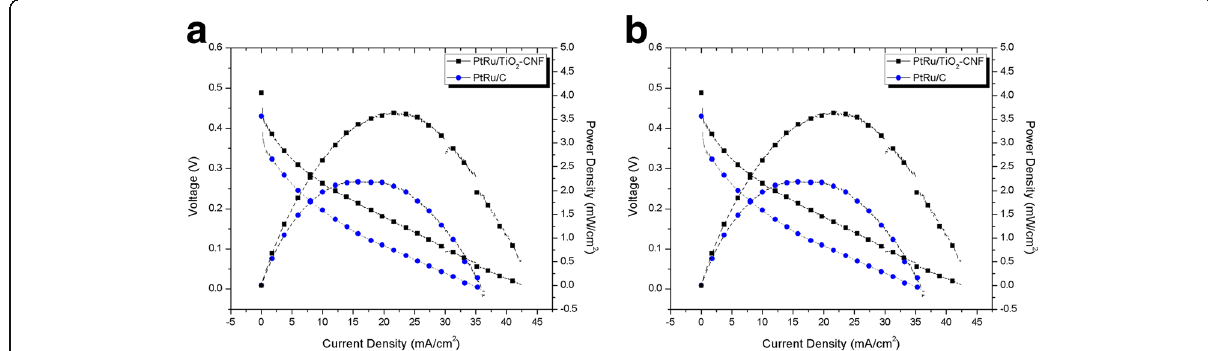
Fig. 8 Current – voltage curve for PtRu/TiO 2 -CNF and PtRu/C in 3 M methanol with 2 mg cm − 2 catalyst loading at room